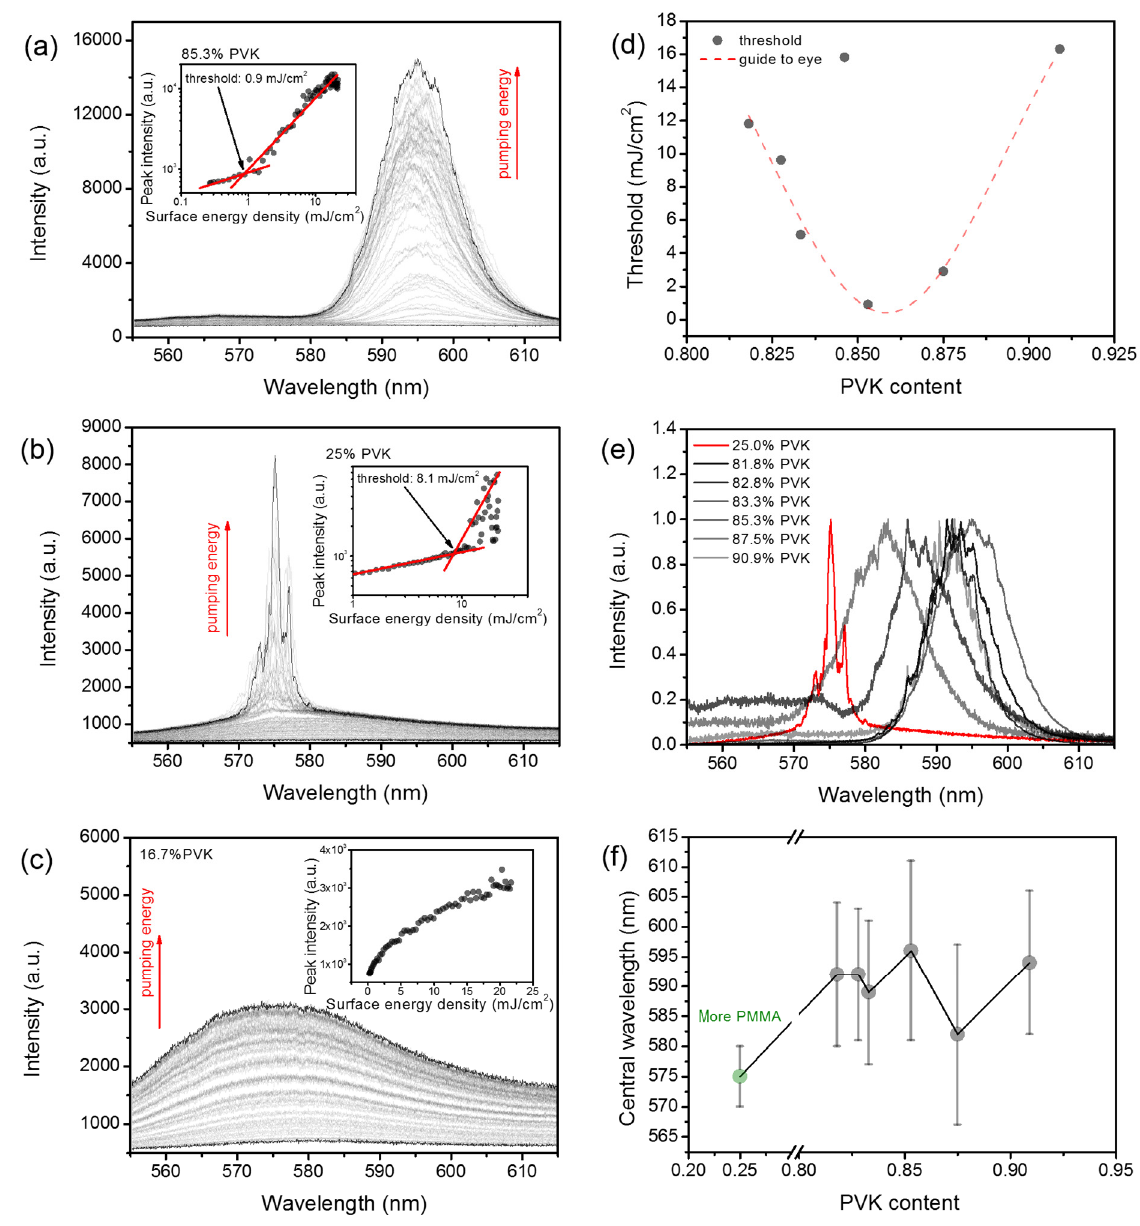
Figure 4. RL spectra, obtained for samples with 85.3% ( a ) and 25% ( b ) of PVK content and their evolution upon increasing pumping fluence. Insets are showing emission intensity dependencies on pumping fluences for both samples. Lasing thresholds are easily recognizable; ( c ) an example of spontaneous emission spectra and the evolution of its intensity in the function of pumping fluence (inset) , obtained for a sample with 16.7% of PVK; ( d ) the threshold dependency on PVK content; ( e ) a comparison of normalized RL spectra captured for different samples at the pumping fluence equal to 22 mJ/cm 2 ; ( f ) the plot of the central wavelength of RL spectra as the function of PVK content. Error bars indicate RL bandwidths measured at the bottom of RL spectra.